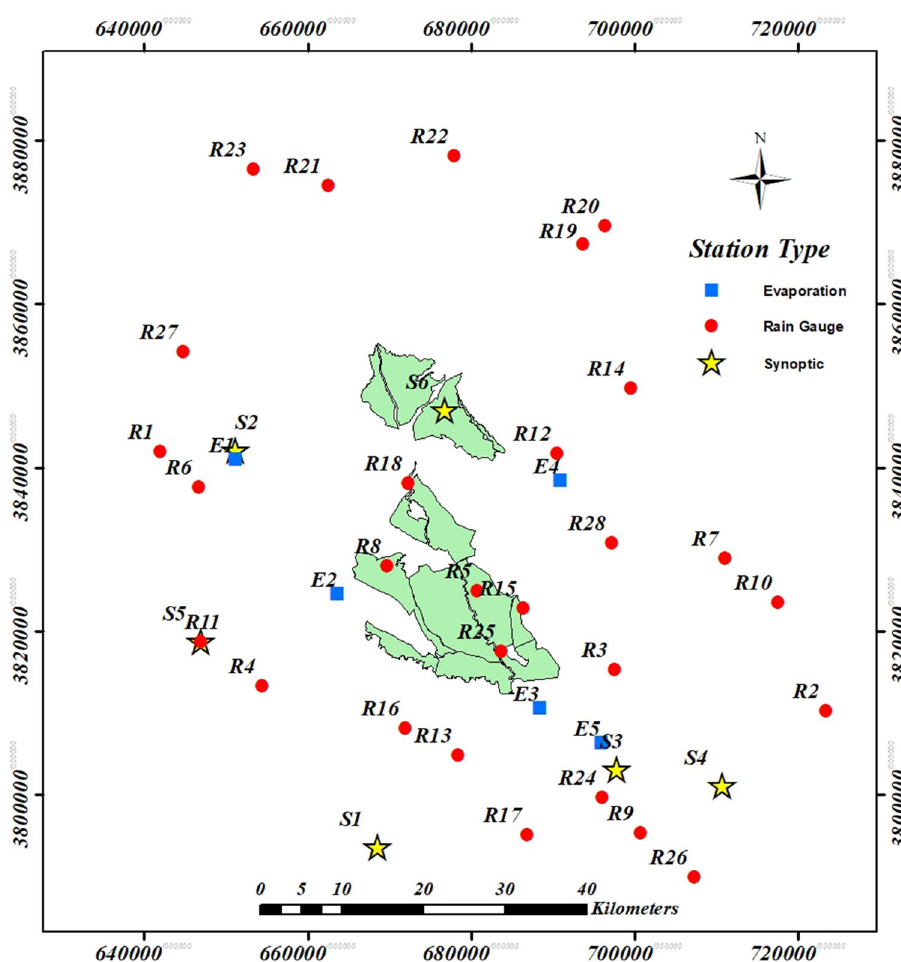
Fig. 4 Location and type of weather